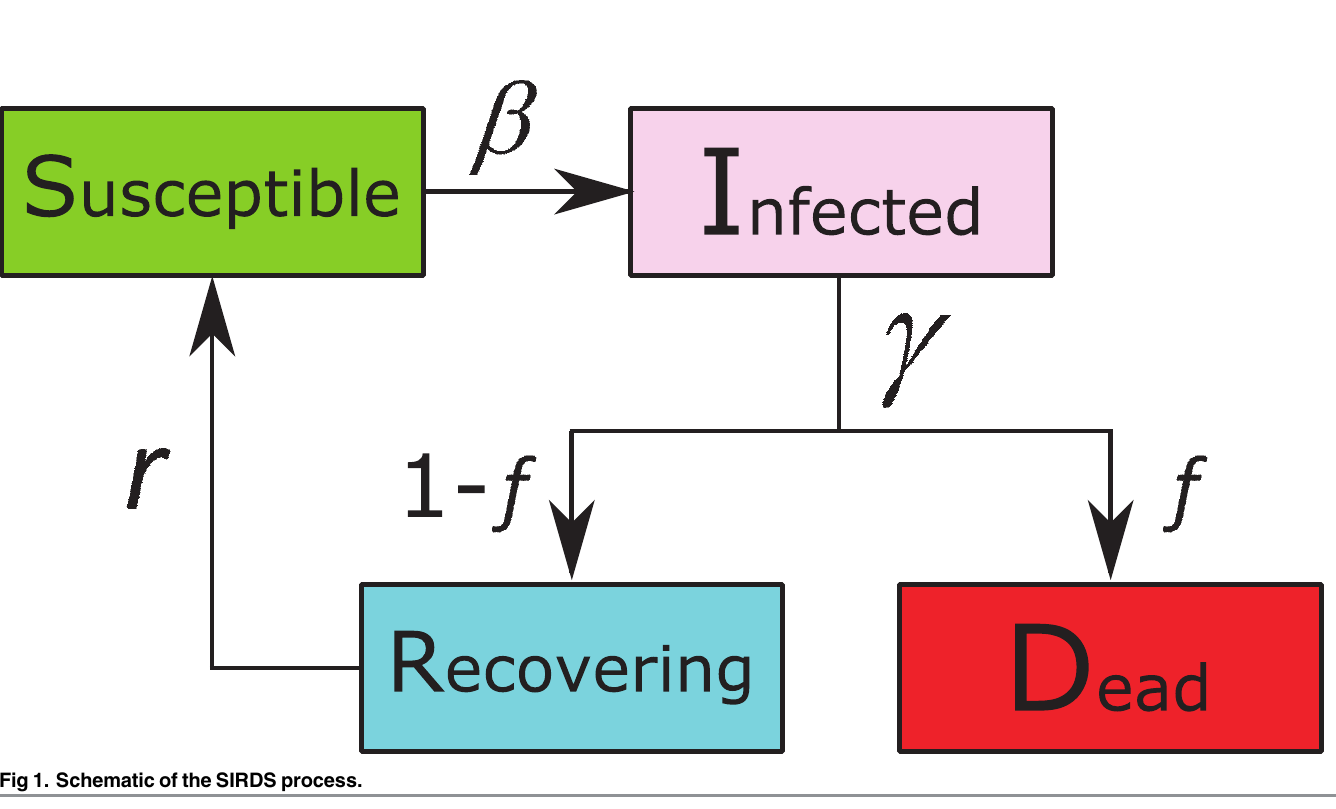
Fig 1. Schematic of the SIRDS